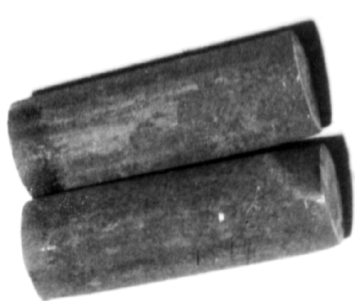
Figure 11. Workpieces of steel cut in the stamp of new design 4.